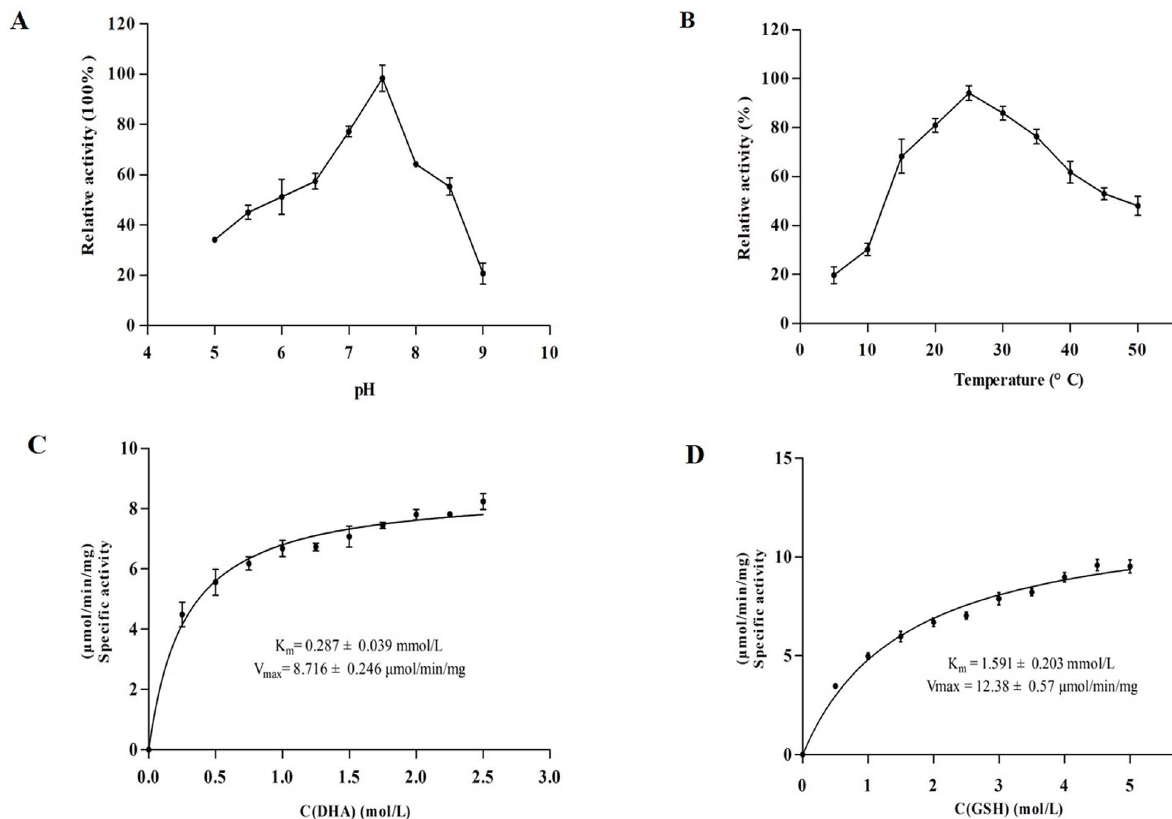
Figure 3. Determination of biochemical properties of GSTO2 of F. hepatica . (A) and (B) show the effects on catalytic activity of rGSTO2 protein measured at different pH (5.0 – 9.0) and different temperatures (5 – 50 (cid:3) C) in potassium phosphate buffer (50 mM, pH 7.4) containing 1 mM GSH and 0.25 mM DHA, respectively. (C) and (D) represent the apparent K m and V max of rGSTO2 protein measured with GSH and DHA as substrates at different concentrations of DHA (0 – 2.5 mM) and GSH (0 – 5 mM) at 25 (cid:3) C, pH 7.5,